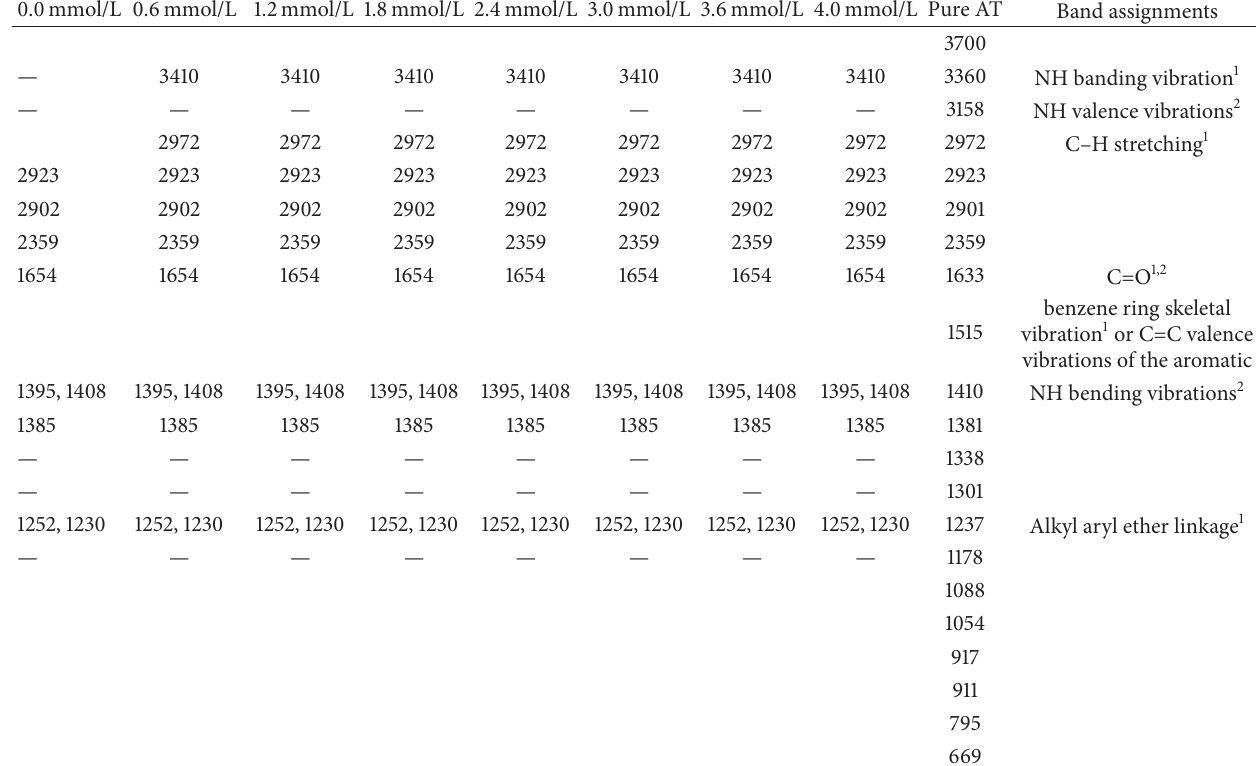
Table 2: FTIR bands for AT and AT adsorbed on